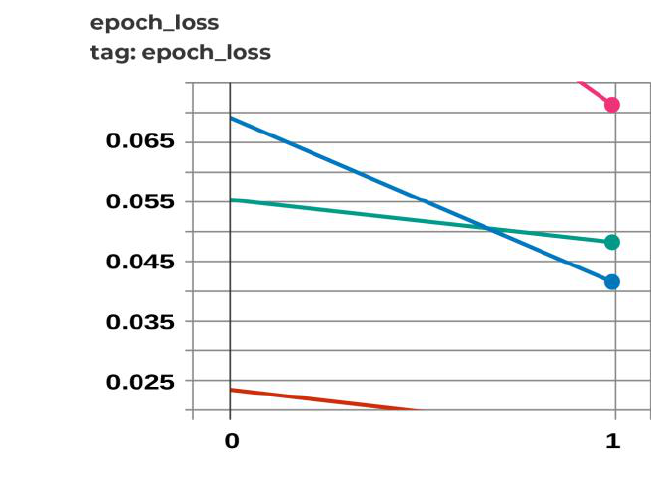
Figure 7. Epoch vs. Accuracy and Epoch vs. Loss. Important features with scores are presented in Figure 8.